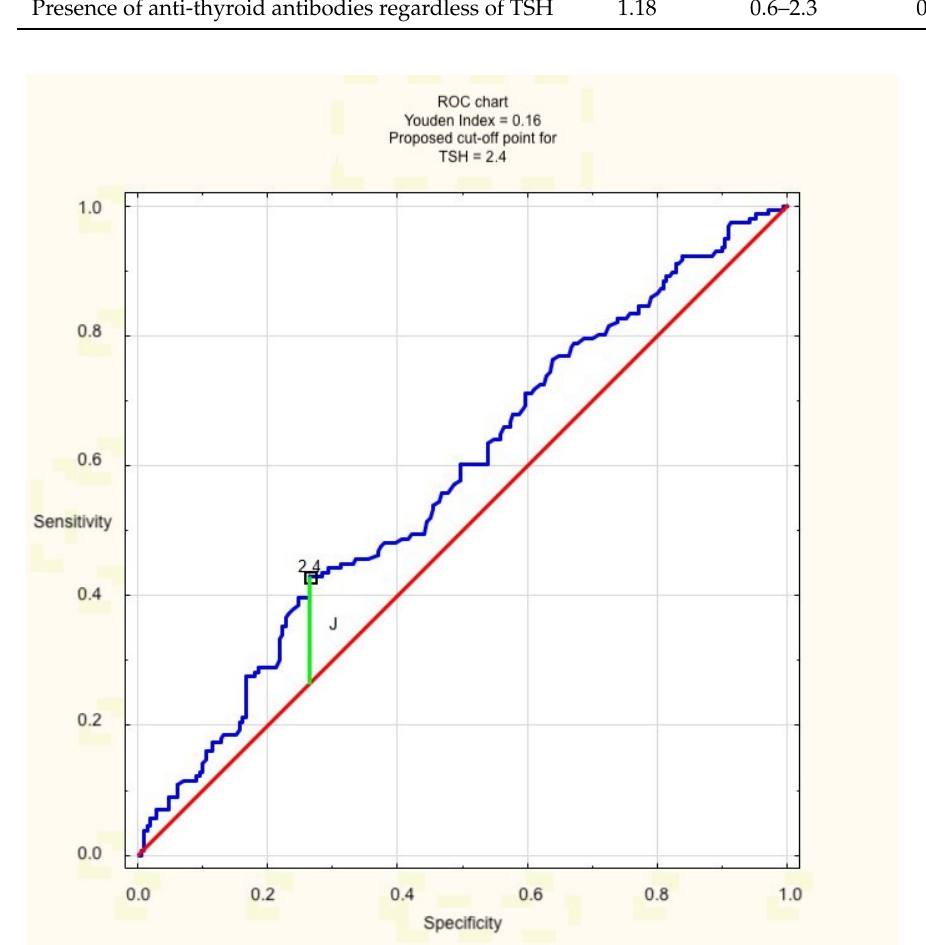
Figure 1. ROC curve for TSH cut-off point. J = Youden’s Index.